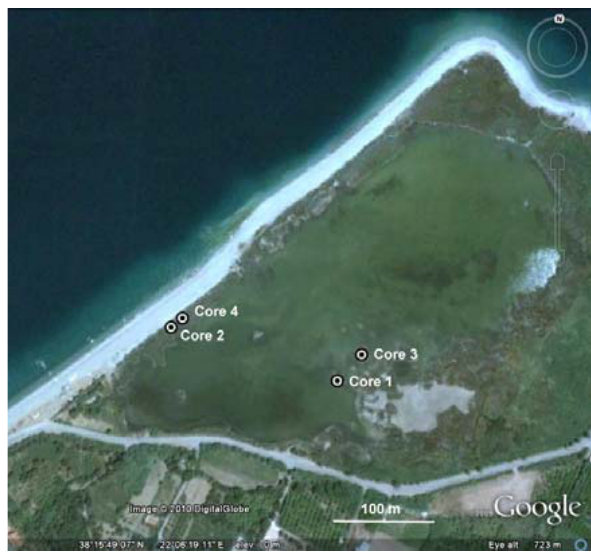
Fig. 3. The field site of Aliki lagoon from a Google